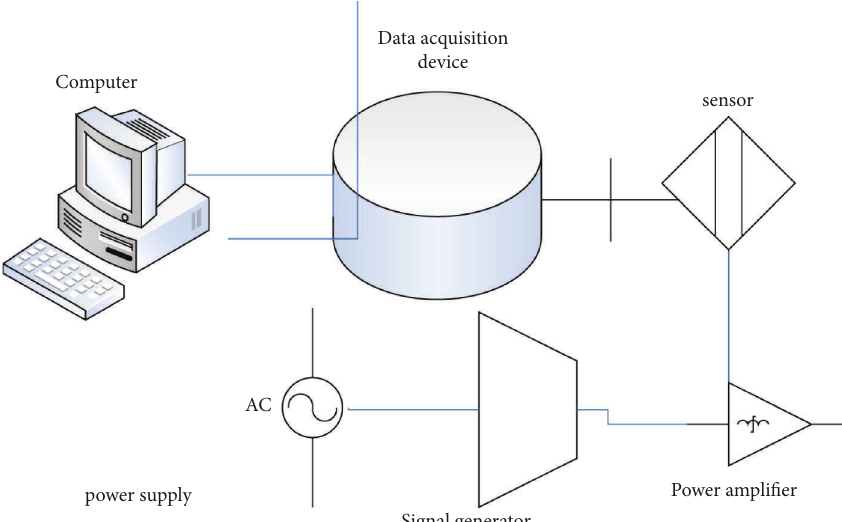
Figure 6: The overall scheme of the experimental system.